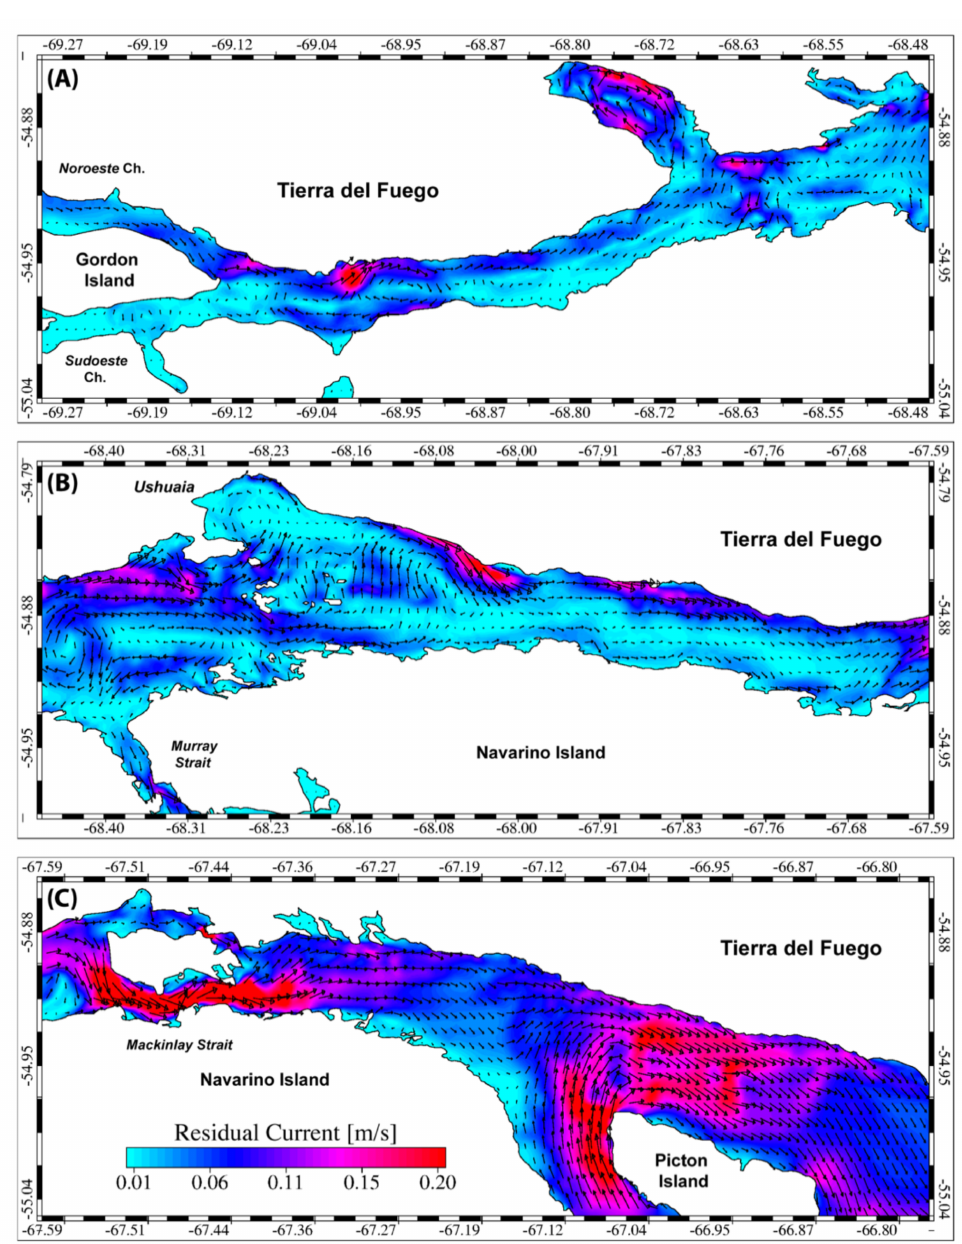
Figure 6. Vertically averaged residual circulation computed for the whole simulated year (2016) and for the whole central BC, subdivided into western ( A ), middle ( B ) and eastern ( C )